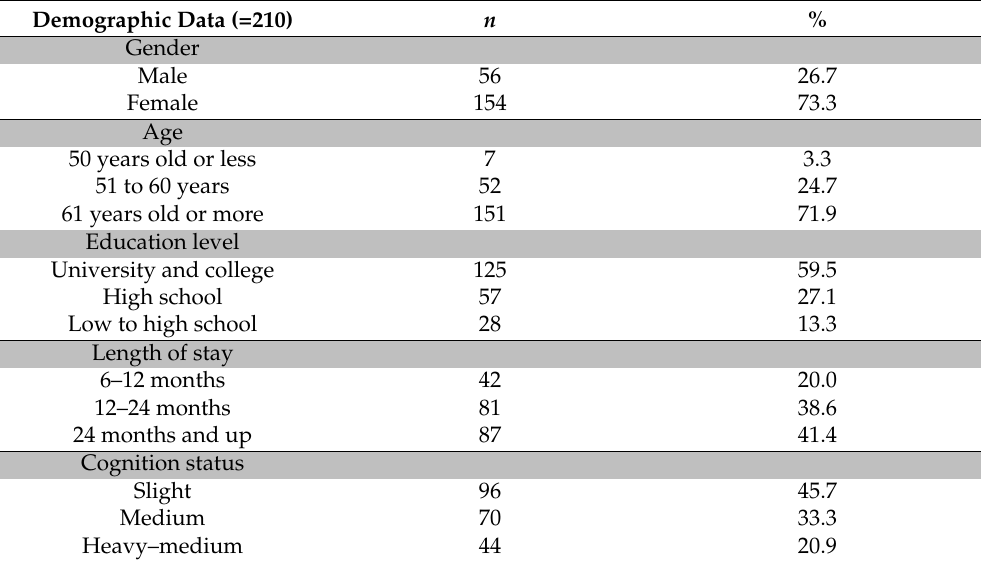
Table 1. Demographic profile of the